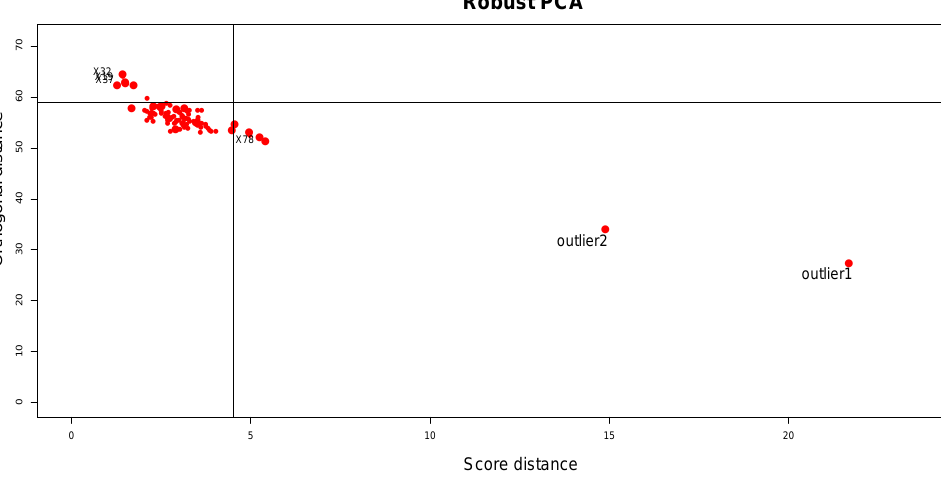
Figure 5. Circular dendrogram of first artificial dataset. The two classes are clustered correctly, respectively, in blue and in red. From the graph, it can be seen that the samples moved from one class to another (in the labels underlined with the word “shift”) are repositioned in the correct class. The two samples with different distribution are in green.